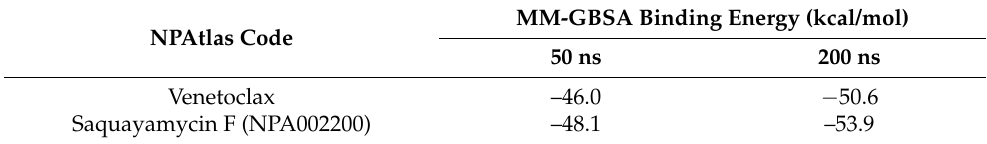
Table 2. The calculated MM-GBSA binding energies of venetoclax and saquayamycin F with the Bcl-2 protein over 50 and 200 ns MD